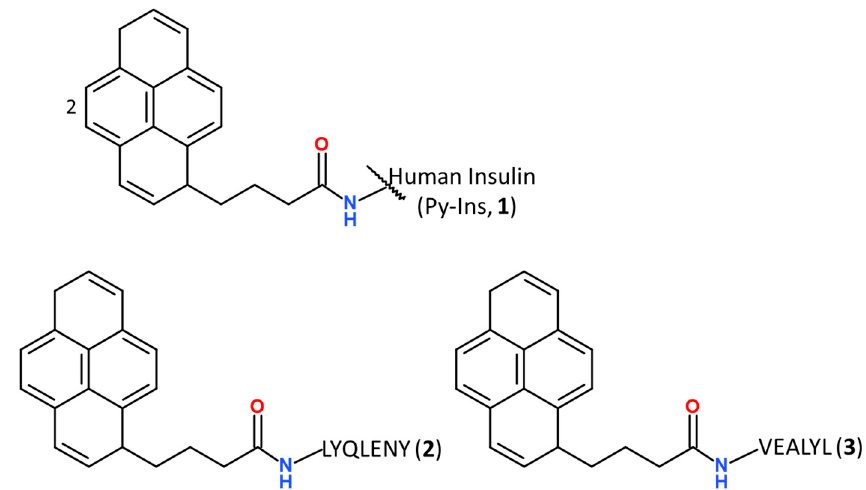
Figure 1. The structure of labeled insulin ( 1 ) and insulin amyloidogenic cores ( 2 , 3 ) with 4-(1-pyrene)butyric acid.